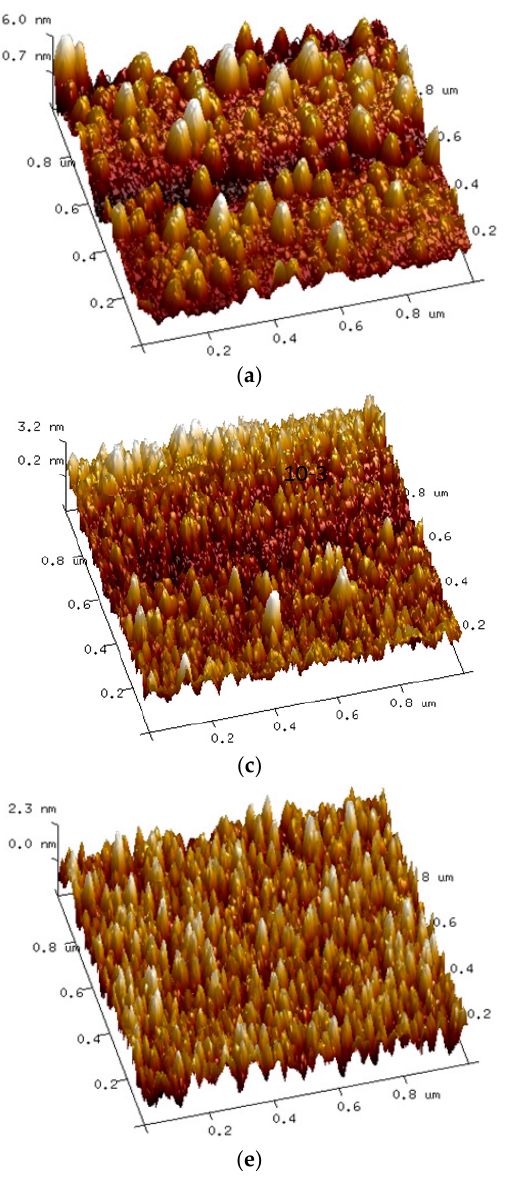
Figure 3. AFM images of TaN films with different nitrogen flow ratios: (a) 2.5%, ( b ) 5%, ( c ) 10%, ( d ) 15%, ( e ) 20%, ( f ) 25%.